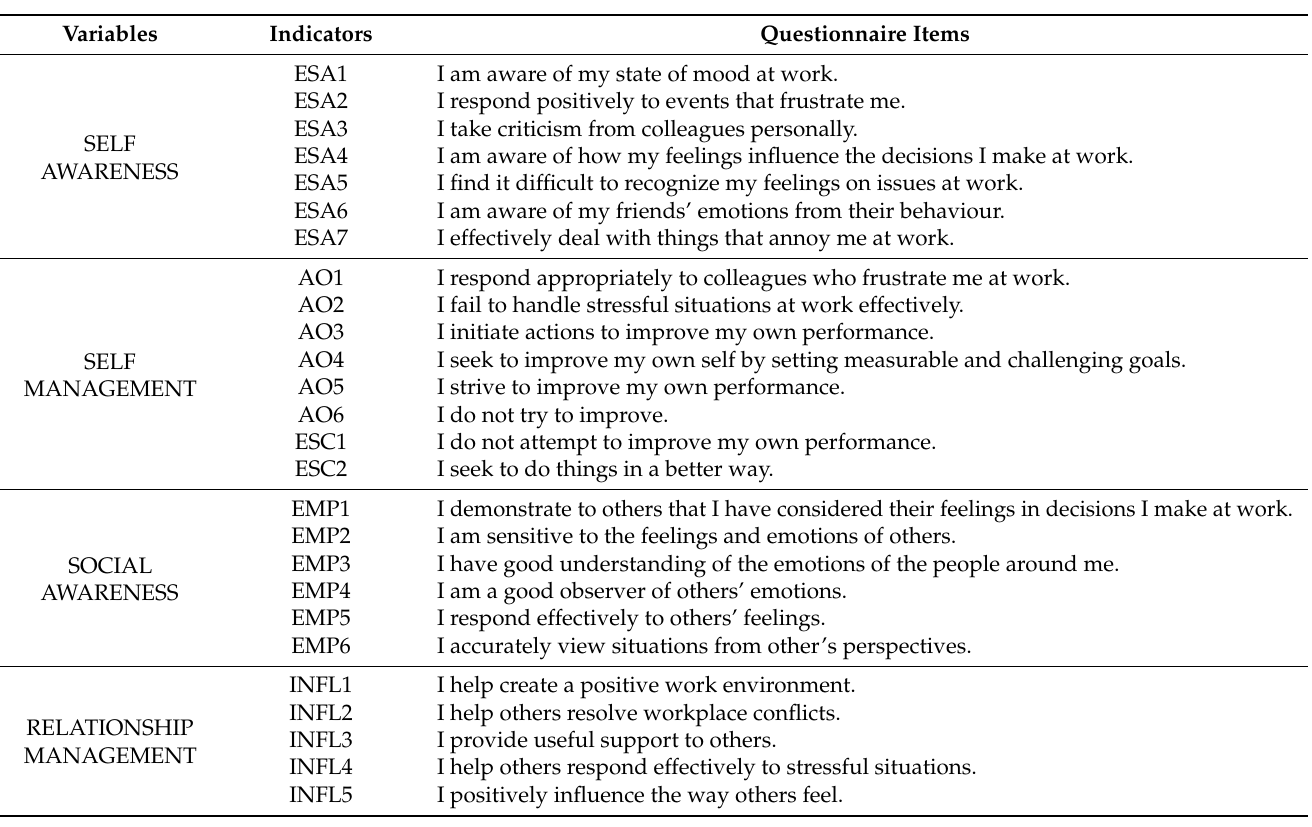
Table A1. Questionnaire items addressing the EI variables and indicators.